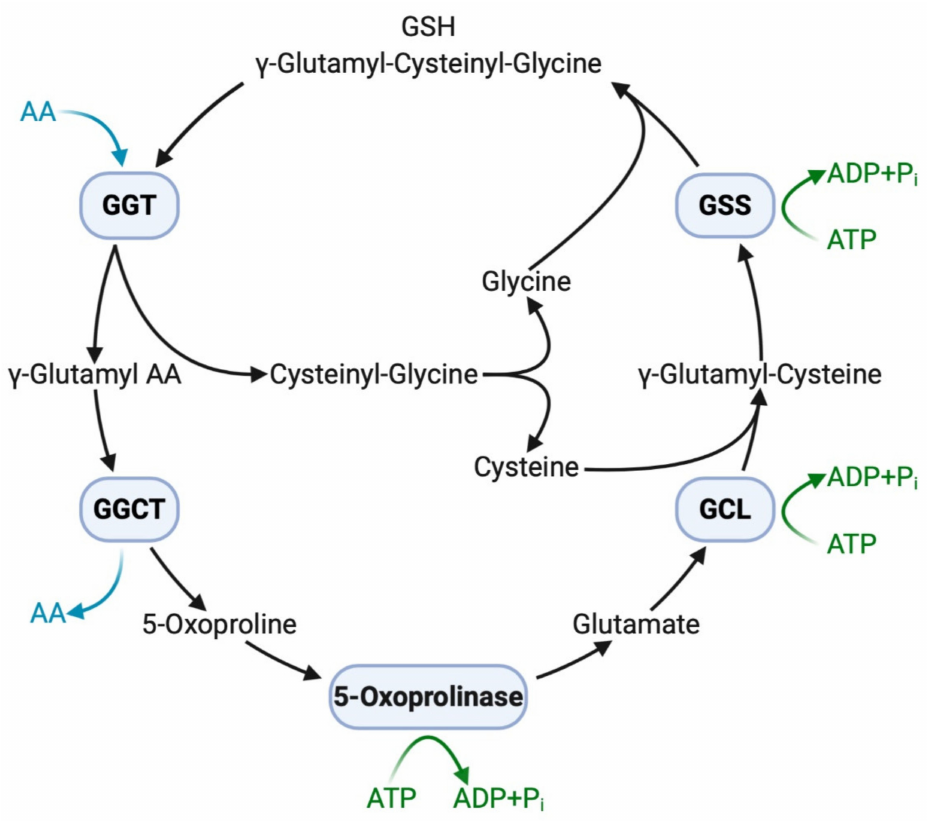
Figure 1. GGT and other enzymes in the γ -glutamyl cycle. Extracellular GSH ( γ -glutamyl–cysteinyl–glycine) is broken down on the cell membrane by membrane-bound GGT, making component peptides available to cells with successive reactions with other enzymes. Intracellular GSH is then resynthesized, increasing resistance to oxidative stress. AA, amino acid; ADP, adenosine diphosphate; ATP, adenosine triphosphate; GCL, glutamate-cysteine ligase; GGCT, γ -glutamylcyclotransferase; GGT, γ -glutamyltransferase; GSH, glutathione; GSS, glutathione synthetase; P i , inorganic